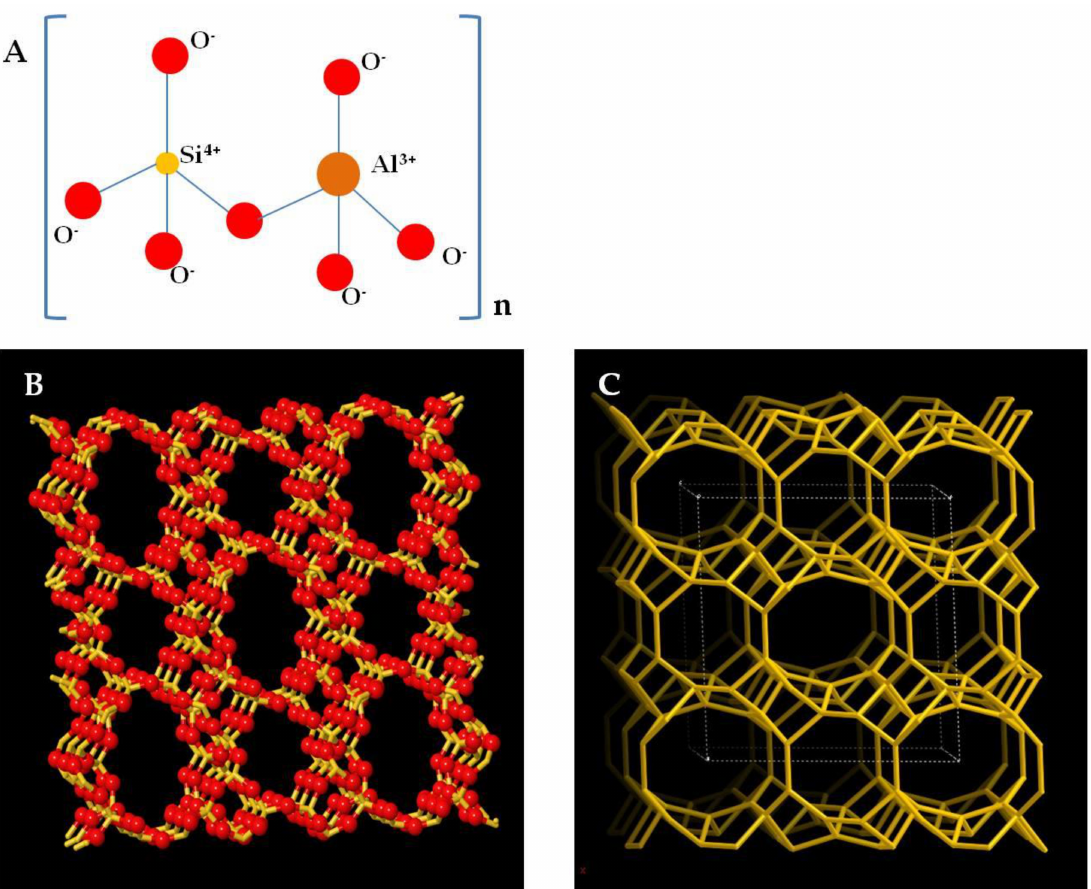
Figure 1. ( A ) AlO 4 and SiO 4 tetrahedrons joined by oxygen atoms that constitute the reticular structure of the zeolite. ( B ) and ( C ) Clinoptilolite framework type by http: // www.iza-structure.org /